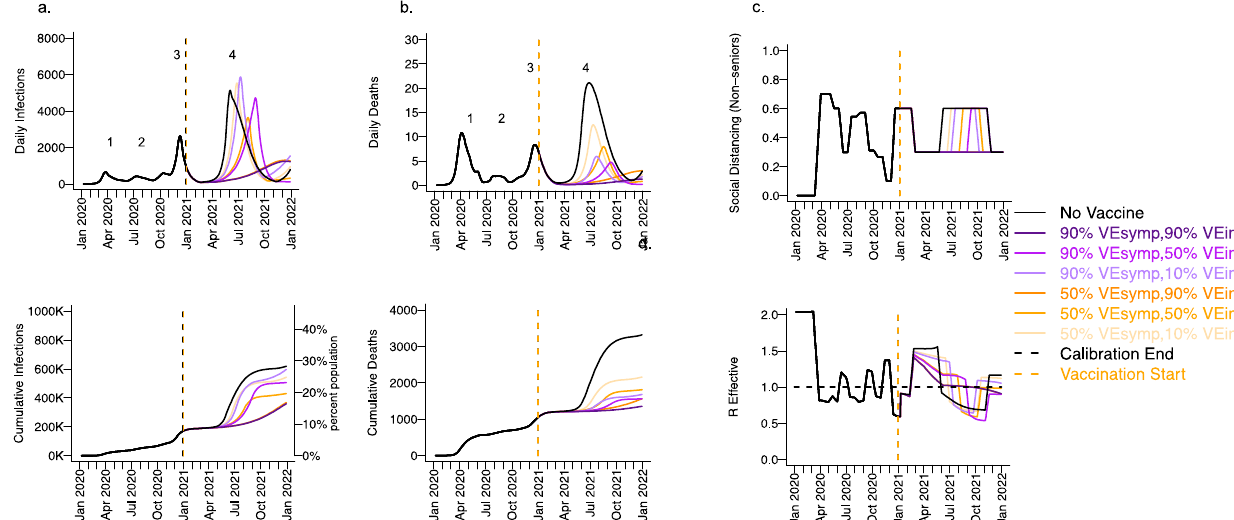
Figure 4. High VE SYMP alone results in only partial reduction in infections and deaths with the B.1.1.7 variant. For unvaccinated (black lines) and each vaccine cohort (colored lines), we project ( a ) infections, ( b ) deaths, as well as ( c ) physical distancing relative to pre-pandemic levels and ( d ) the effective reproductive number. The first two columns ( a , b ) are organized by row: top = daily incidence and bottom = cumulative. Waves of infection are numbered 1-4. Six combinations of VE SYMP and VE INF are considered while VE SUSC is fixed at low 10%. High VE SYMP (90%) simulations are purple. Moderate VE SYMP (50%) simulations are orange. Dark lines are high VE INF (90%). Moderate darkness lines are medium VE INF (50%). Light lines are low VE INF (10%). The largest reduction in cases is associated with high VE INF . 10,000 vaccines are given per day starting 1 January 2021 (orange dashed vertical line) until 90% are vaccinated in age groups other than children. Case threshold for reinstituting physical distancing to 0.6 is 350 per 100,000 and for relaxation is 100 per 100,000. 80% of vaccines are initially allocated to the elderly.